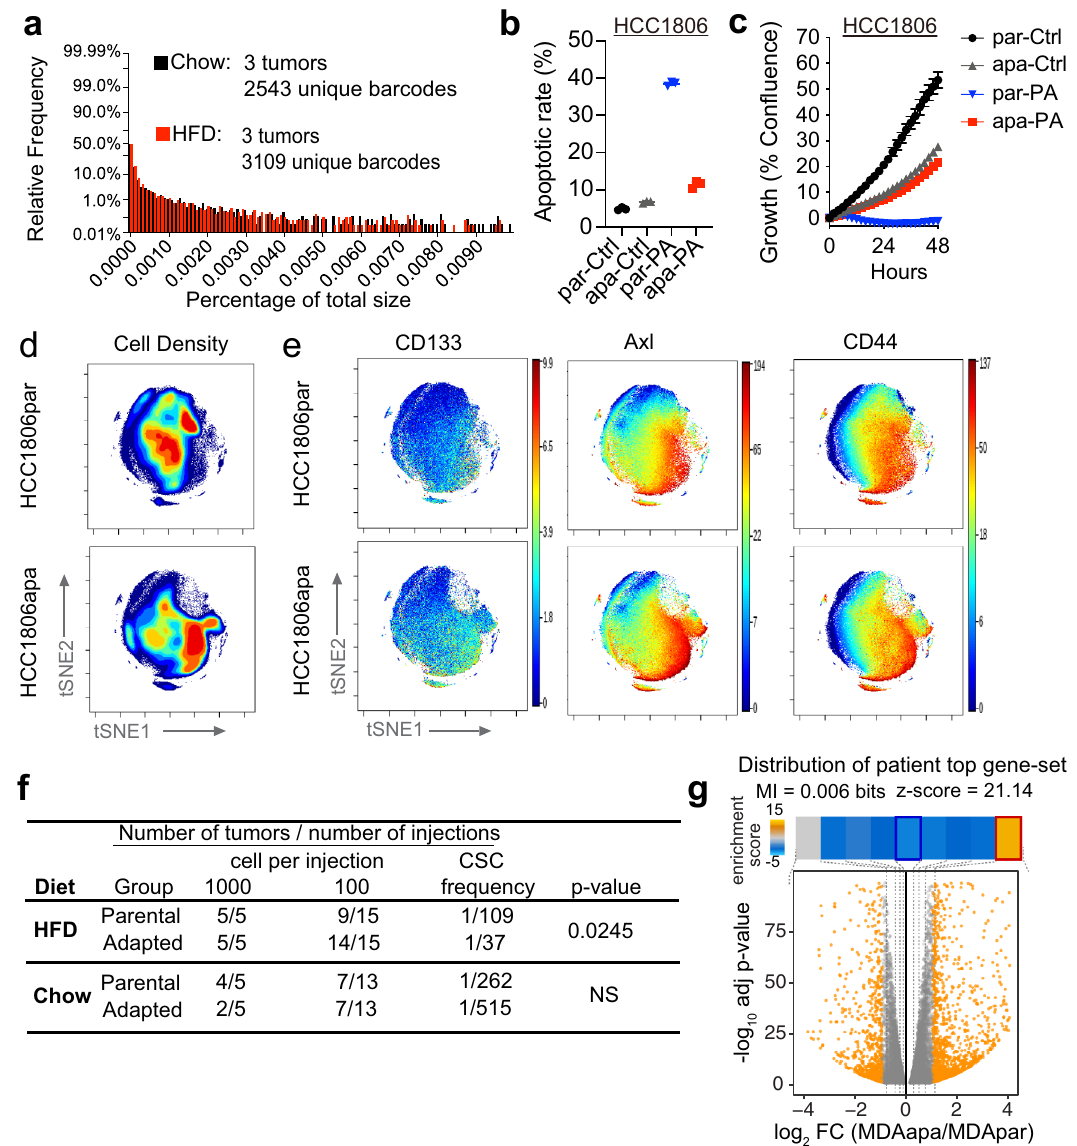
Fig. 2 Long-term adaptation to PA phenocopy obesity-induced stem-cell features. a Distributions of relative barcode frequency for three tumors in each group. b Apoptotic rate of parental and adapted HCC1806 cells which were treated with 400 µ M PA and vehicle (Ctrl) for 48h. Both early (Annexin V + /PI − ) and late (Annexin V + /PI + ) apoptotic cells were included for the apoptotic rate % calculation. Data are represented as mean±SEM of 3 replicates. c Time- dependent proliferation assay of parental and adapted HCC1806 following 48h. Cells were exposed to 400 µ M PA and vehicle (Ctrl). Cell growth was determined by high content imaging and represented as % con fl uence normalized to t = 0. For each time point, data are represented as mean±SEM of 6 replicates. d Representative contour plots of mass cytometry data colored by density of cells showing the changes between parental and adapted HCC1806 cells. Color code represents the cell density from low (blue) to high (red). e Representative tSNE plots of single parental and adapted HCC1806 cells colored by expression of CD133, Axl, and CD44. f Tumor incidence following orthotopic implantation of the indicated number of parental and adapted E0771 cells into chow and HFD-fed mice. The frequency of cancer stem-like cells was calculated by the extreme limiting dilution analysis. The default Chisquare test in ELDA was performed to evaluate the differences between parental and adapted cells (NS, P value >0.05). g The distribution of genes induced by obesity (obese and overweight compared to non-obese patients) in PM hormone negative breast cancers patients among the gene expression changes observed in PA-adapted cell lines. We have included the mutual information value (MI) and its associated z-score reported by iPAGE. For visualization, the enrichment/depletion of the query gene-set was determined using the hyper-geometric test and the resulting p-value was used to de fi ne an enrichment score that is shown as a heatmap across the expression bins. The obesity-induced genes were signi fi cantly enriched in the top-most bin. The red and blue borders in the heatmap denoted statistical signi fi cance for enrichment and depletion respectively. Source data are provided as a Source data fi